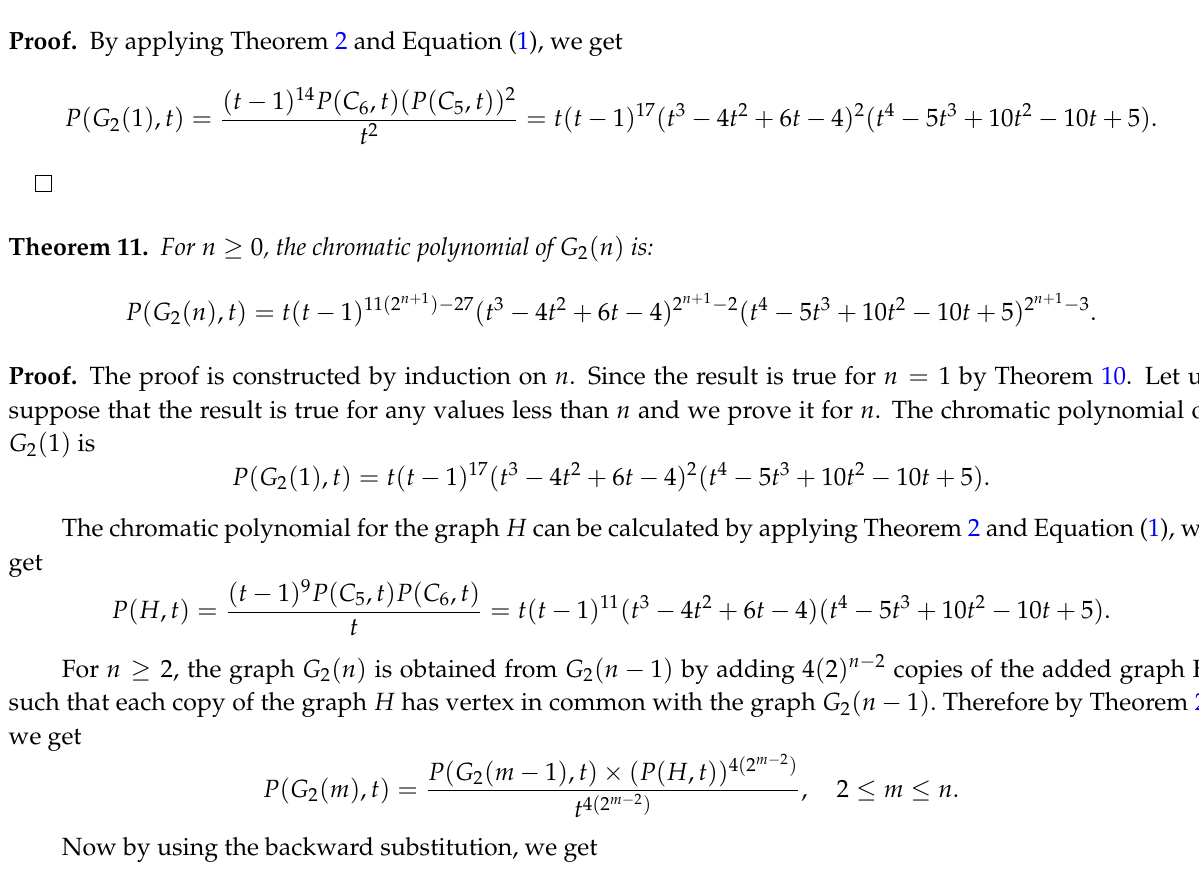
Figure 9. The graph H of added branch of dendrimer nanostar NSC 5 C